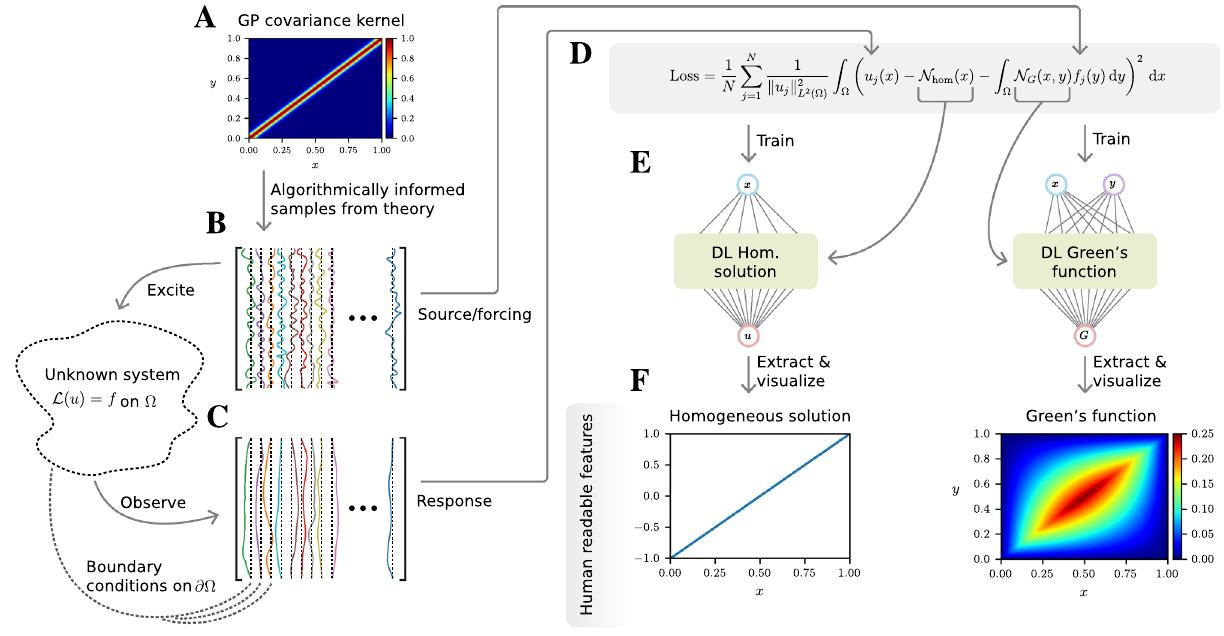
Figure 1. Schematic of our DL method for learning Green’s functions from input-output pairs. ( A ) The covariance kernel of the Gaussian process (GP), which is used to generate excitations. ( B ) The random excitations and the system’s response are recorded ( C ). ( D ) A loss function is minimized to train rational NNs ( E ). ( F ) The learned Green’s function and homogeneous solution are visualized by sampling the